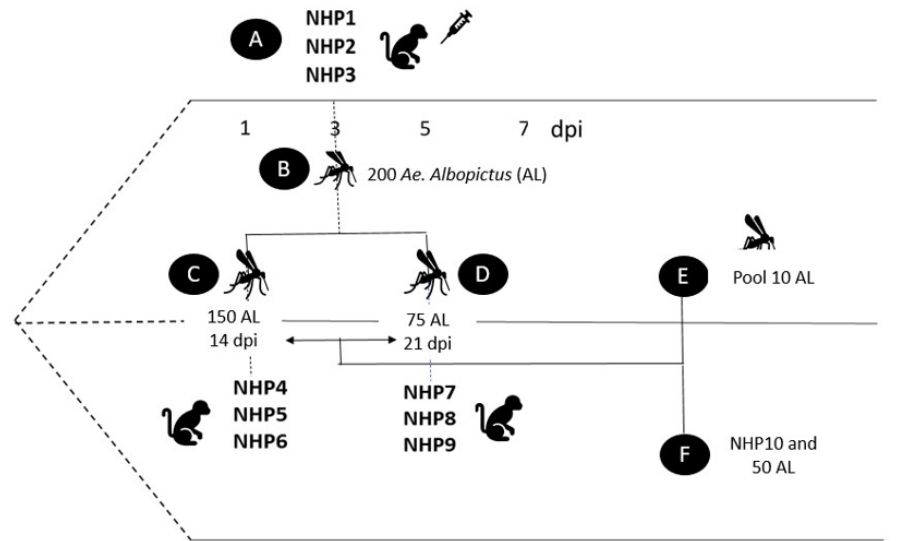
Figure 1. Experimental procedure. Legend: ( A ) Experimental infection of non-human primates (NHP1, NHP2 and NHP3) with YFV; ( B ) NHP exposure to female Ae. albopictus (AL) on 3 dpi; ( C ) Exposure of healthy NHPs (NHP4, NHP5 and NHP6) to female Ae. albopictus on 14 dpi and segmentation of females into thorax, abdomen and head and extraction of saliva; ( D ) Exposure of healthy NHPs (NHP7, NHP8 and NHP9) to females Ae. albopictus on 21 dpi and segmentation of females into thorax, abdomen and head and extraction of saliva; ( E ) Segmentation of female (in thorax, abdomen, head) and saliva extraction, all samples organized in pools of 10 at 14 and 21 dpi; ( F ) NHP (negative control) and 50 mosquitoes used as negative controls.